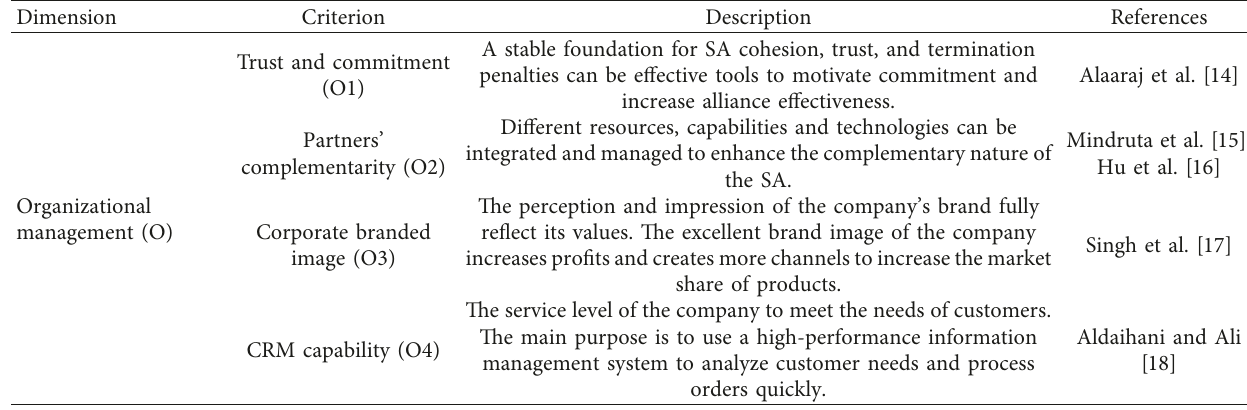
Table 5: The organizational management dimension and its criteria.